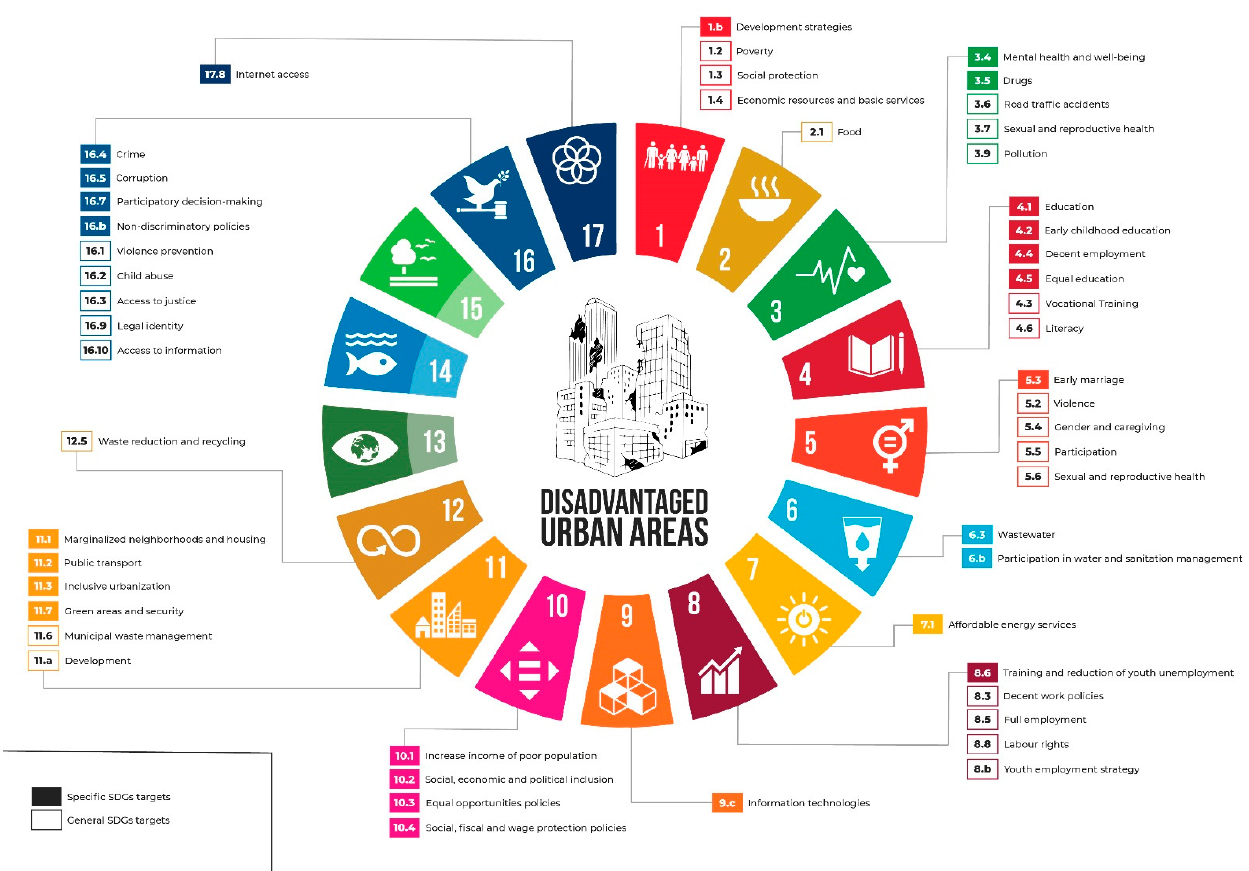
Figure 1. General and specific SDGs to impact disadvantaged urban areas.